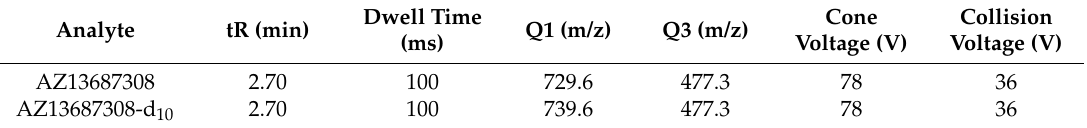
Table 3. MS/MS Parameters for Waters Xevo TQ-S Triple Quadrupole Mass